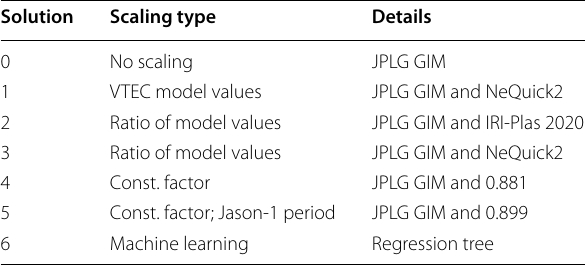
Table 1 Scaling solutions used in this study